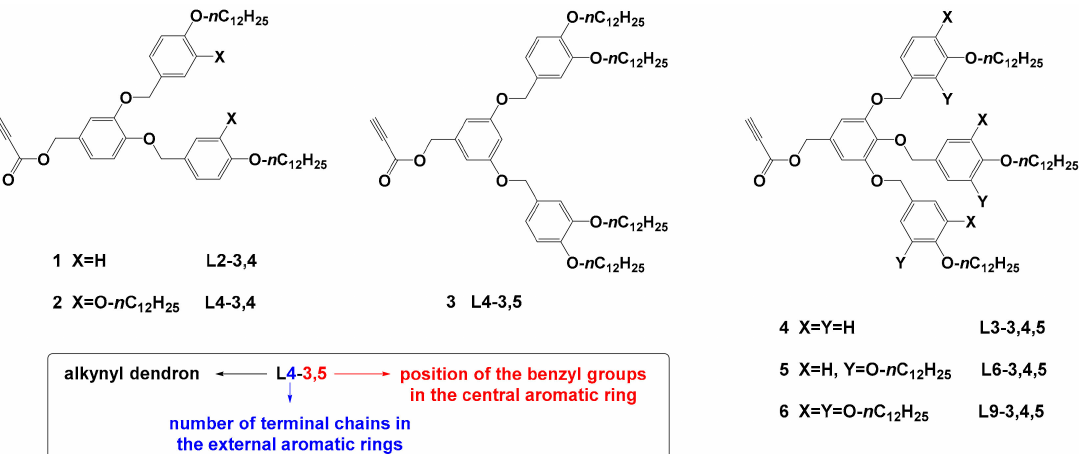
focal point will be denoted Ln, where n corresponds to the total number of hydrocarbon chains. In addition, the substitution pattern is included, that is, the position by which the peripheral benzyl groups are linked to the central benzene ring. Thus, ligand 1: ≥ L2-3,4; ligand 2: L4-3,4; ligand